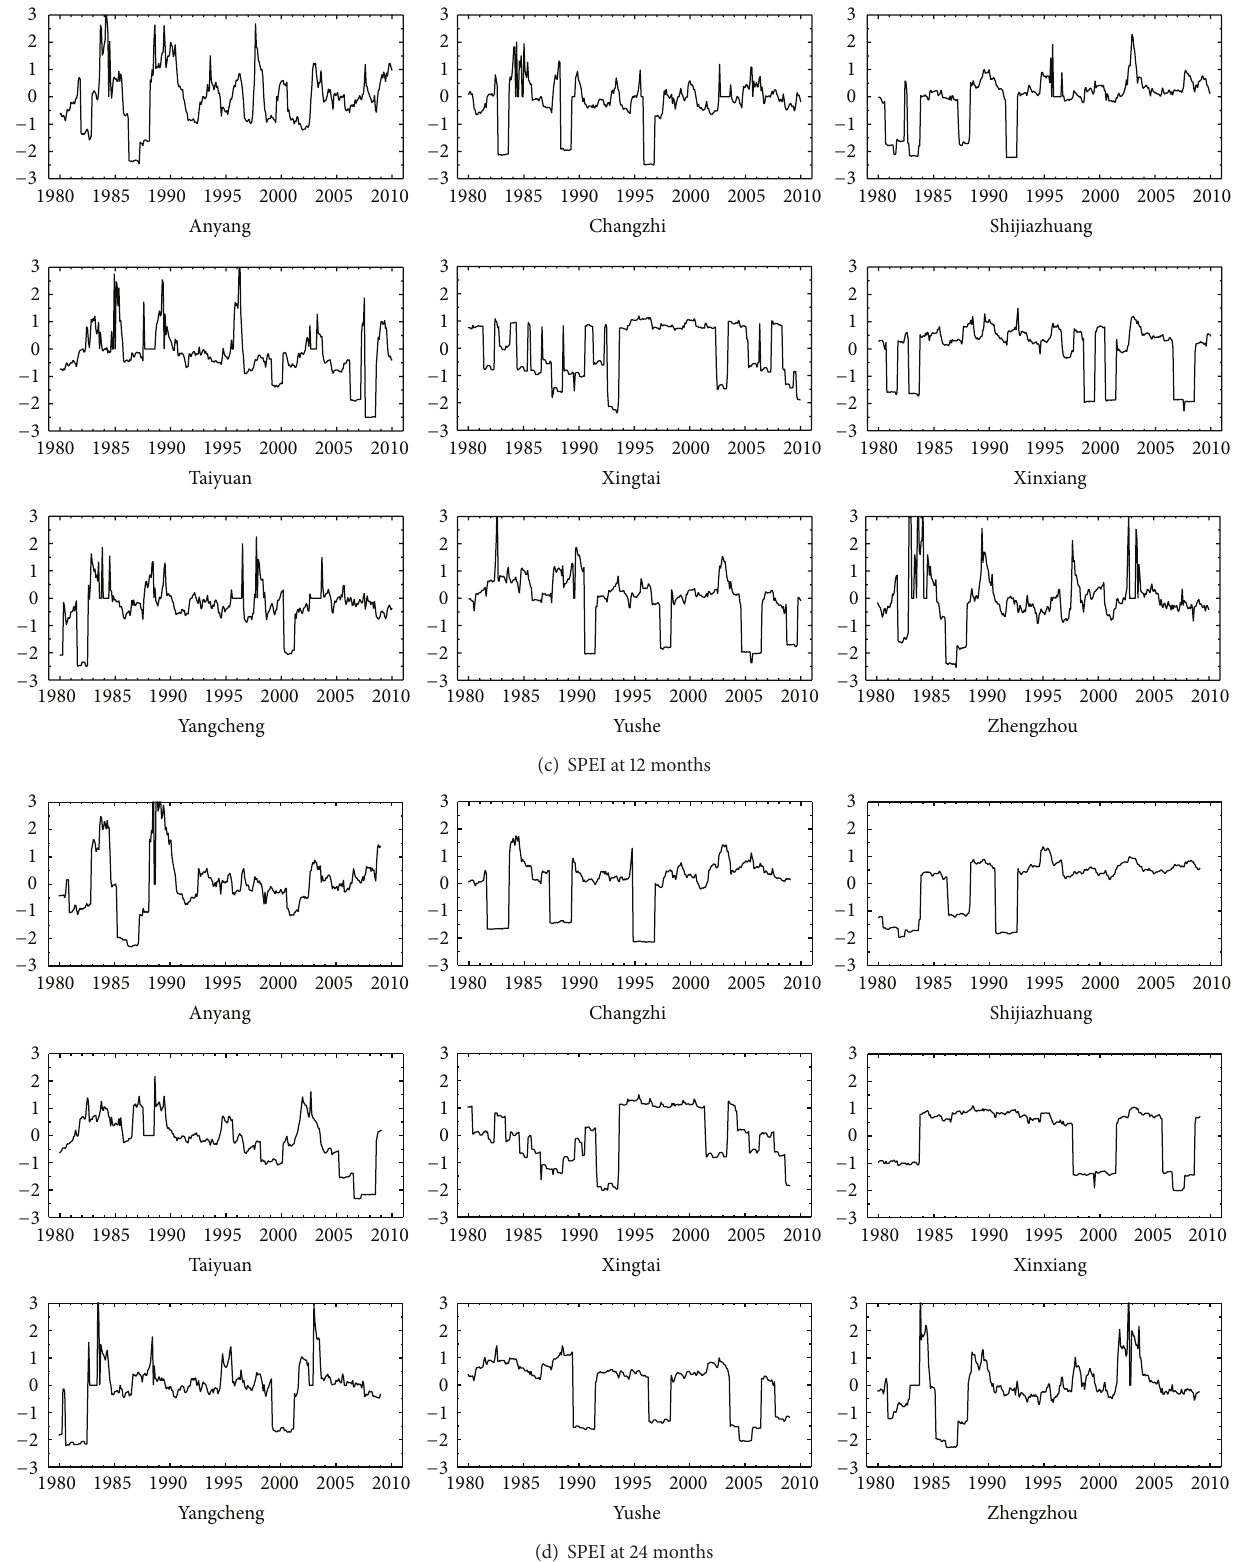
Figure 2: SPEI time serous at 1, 6, 12, and 24 months’ time